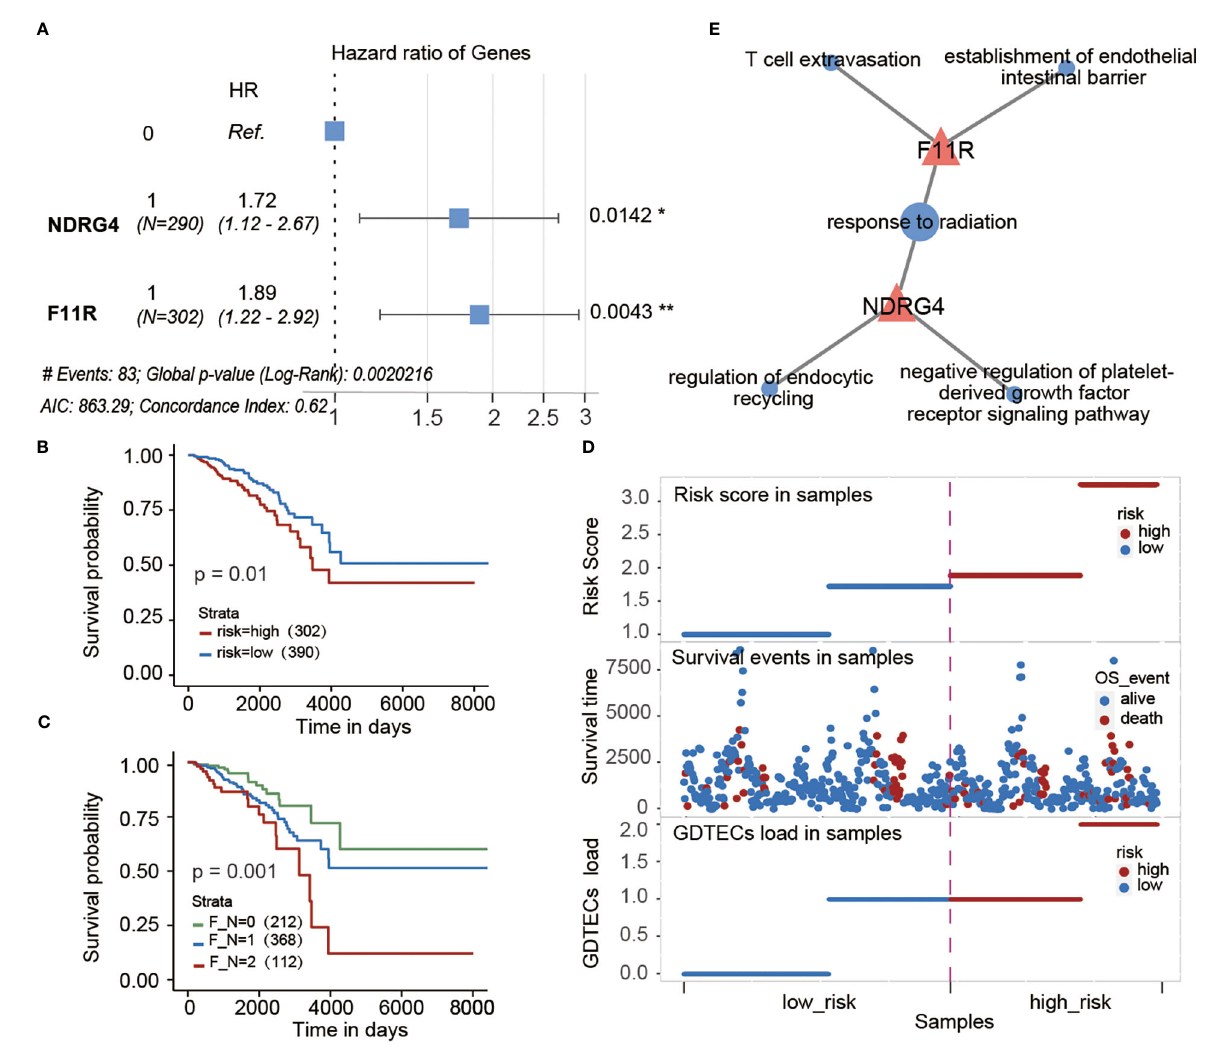
FIGURE 8 (A) Multivariate cox regression model constructed with the GDTEC expression of NDRG4 and F11R as features. The hazard ratios are shown with 95% con fi dence intervals (Wald test, '*'p < 0.05, '**'p < 0.01). (B) Kaplan-Meier survival chart of low-risk and high-risk breast cancer patients. (C) Kaplan-Meier survival chart of the three groups of breast cancer patients were grouped according to whether the two risk genes, F11R and NDRG4, express GDTEC. F_N = 0 indicates that both genes do not express GDTEC; F_N = 1 indicates that one of the genes expresses GDTEC; F_N = 2 indicates that both genes express GDTEC. (D) Risk score ranking of patients and their survival status, as well as the risk scores of patients corresponding to the number of genes expressing GDTEC in their 2 risk genes. (E) Functions of F11R and NDRG4 two risk genes involved. Pink triangles represent genes and pink circles represent GO functional